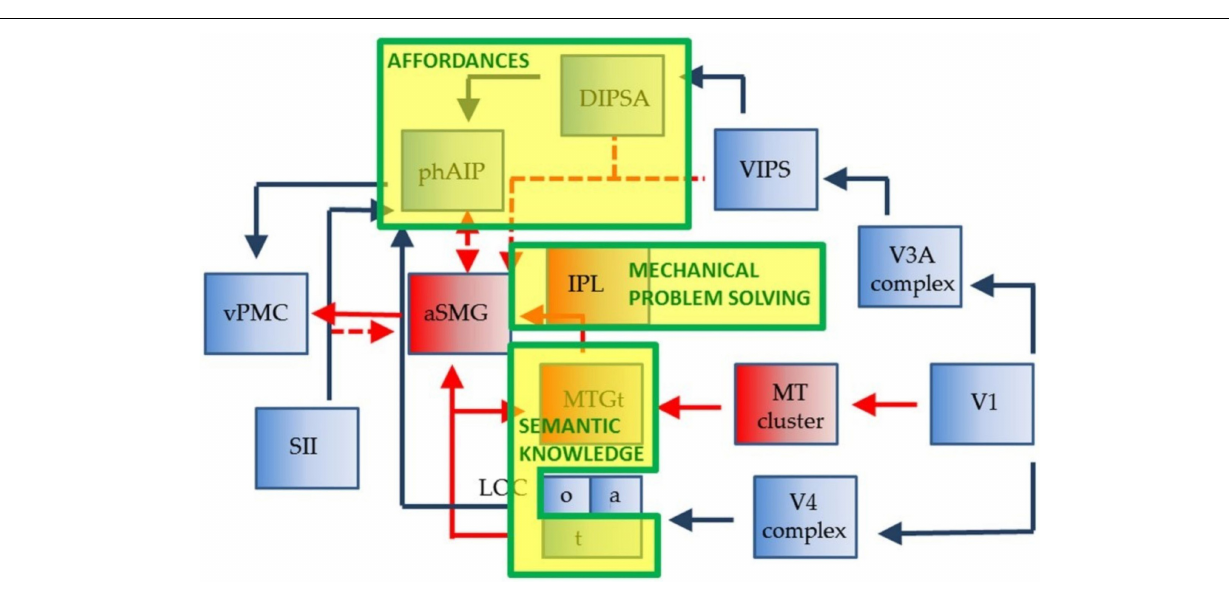
FIGURE 2 | Representation of the human brain network suggested to be involved in tool use, including biological actions in blue, tool actions in red and blue, and cognitive processes in yellow boxes with green outlines. Dashed lines represent postulated connections. Reproduced from Orban and Caruana (2014).